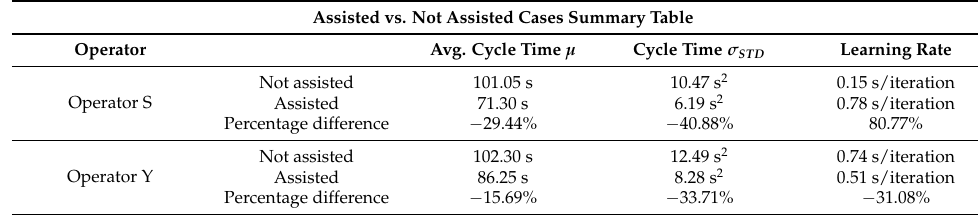
Table 1. Results summary table: Assisted vs Not Assisted. Assisted vs. Not Assisted Cases Summary